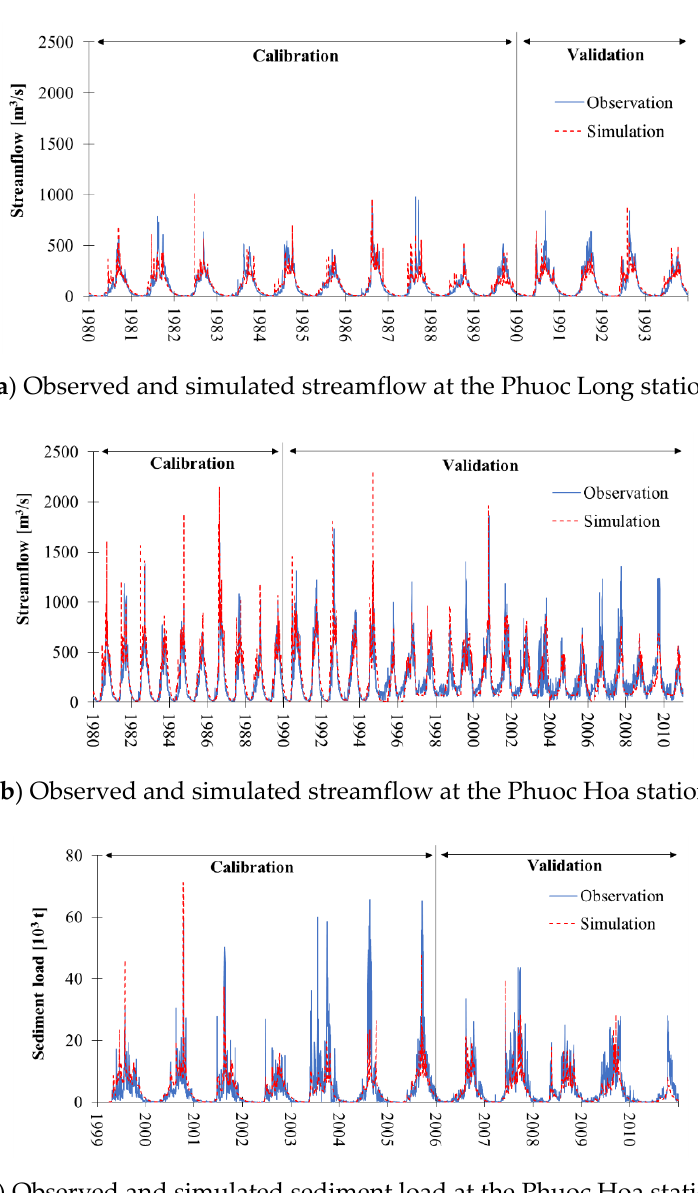
Figure 6. Comparison graphs of observed and simulated values of ( a ) streamflow at the Phuoc Long station, ( b ) streamflow at the Phuoc Hoa station, and ( c ) sediment load at the Phuoc Hoa station for the calibration and validation time periods.